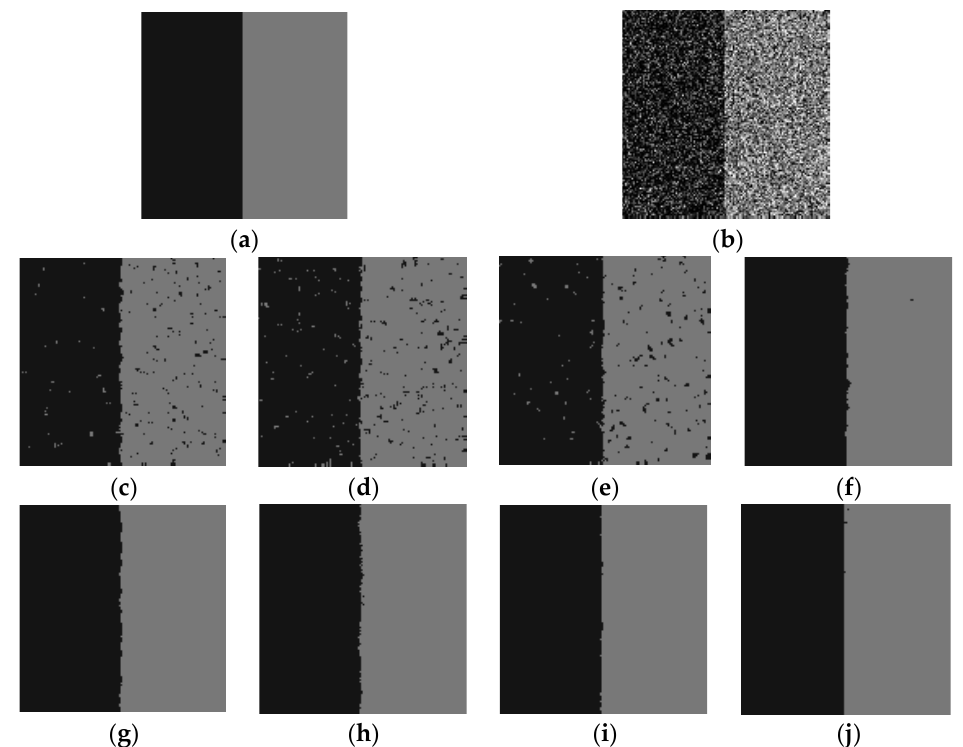
Figure 11. Segmentation results of a synthetic image. ( a ) Original image, ( b ) the same image corrupted by Gaussian noise ( 20% ), ( c ) FCM_S1 result, ( d ) FCM_S2 result, ( e ) FGFCM result, ( f ) FLICM result, ( g ) KWFLICM result, ( h ) FCM_SNLS result, ( i ) CKS_FCM result, ( j ) FCM_NNS result.